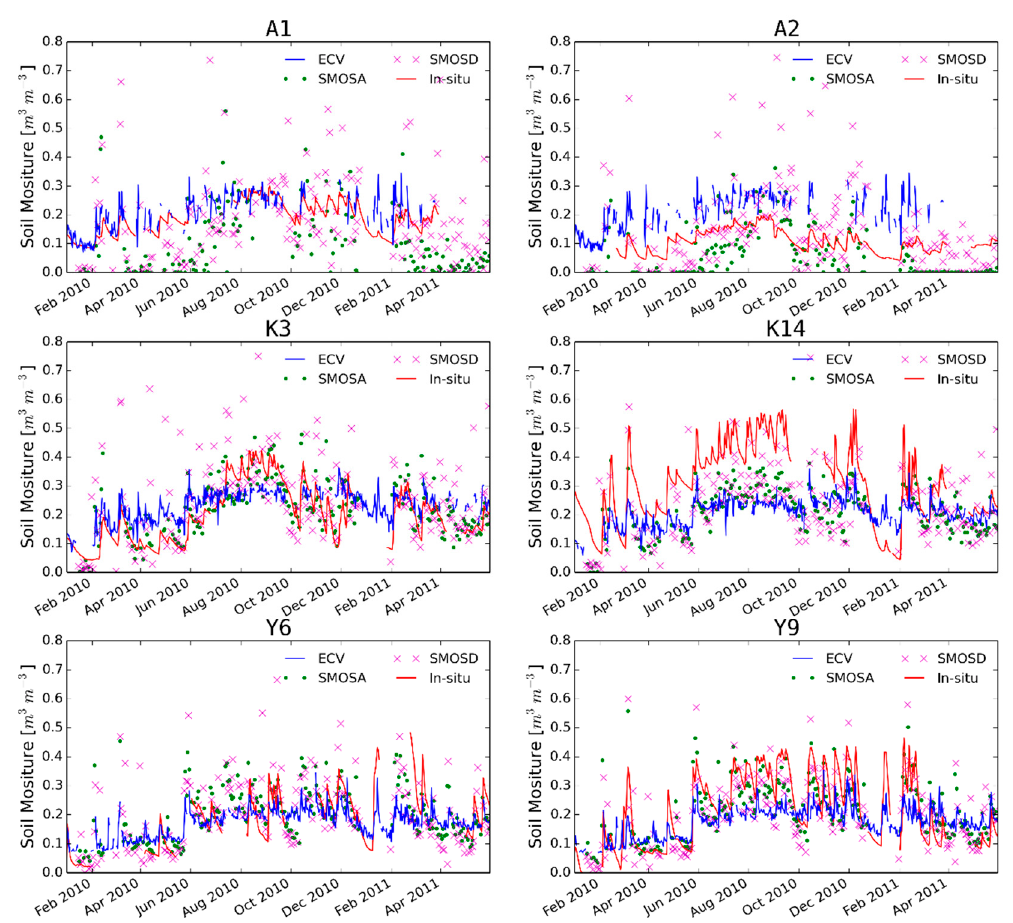
Figure 2. Comparison of temporal behavior of the soil moisture products and in situ measurements at selected Adelong (A1, A2), Kyeamba (K3, K14), and Yanco (Y6, Y9) sites.